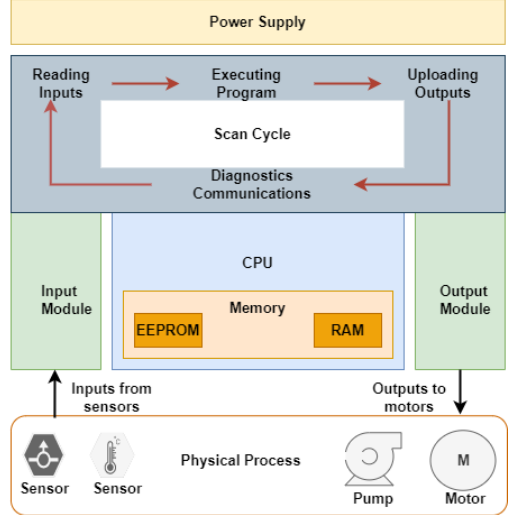
Figure 3. A typical PLC